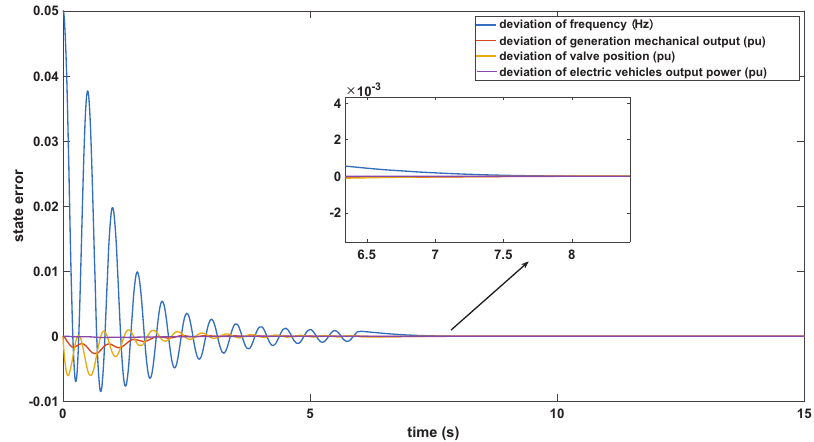
Figure 8. Error trajectory of one-area power